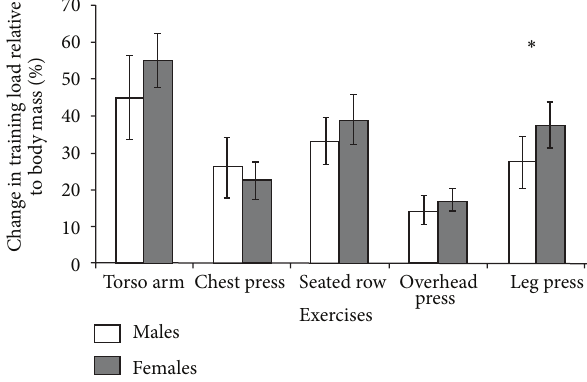
Figure 2: Mean change in training load relative to body mass with 95% CIs for males and females; ∗ significant compared to males ( 𝑃 < 0.05